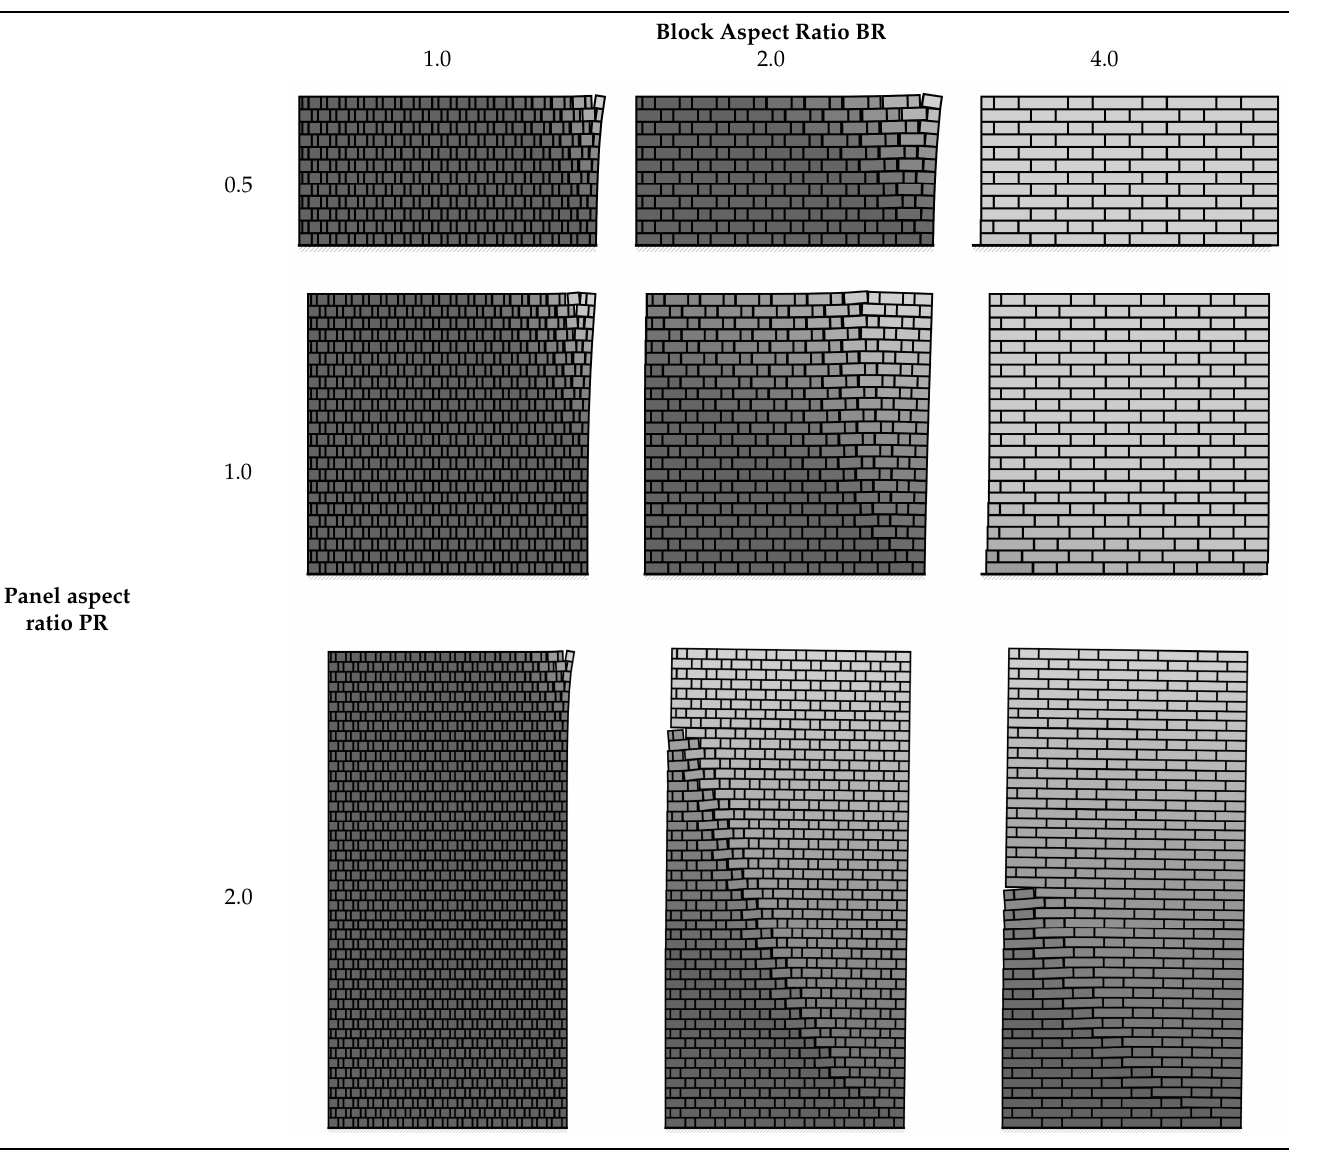
Table A4. Failure Mechanisms for Flemish Bond with µ = 0.50.